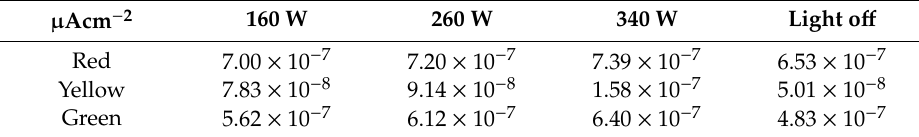
Table 1. The highest current density values for red QDs, yellow QDs, and green QDs at − 0.4